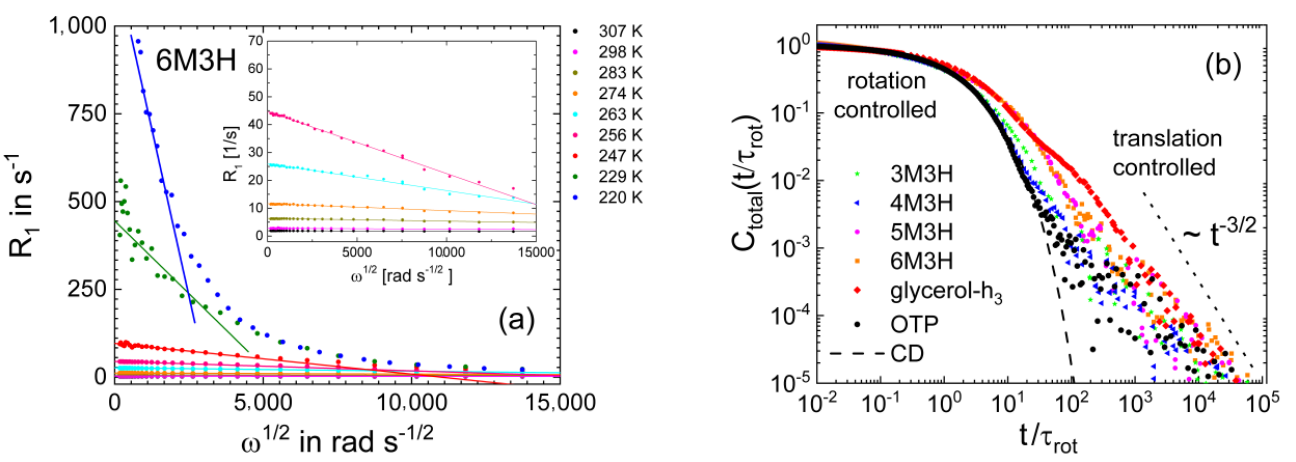
Figure 11. ( a ) 1 H spin-lattice relaxation rate R 1 as a function of the square root of the frequency, ω 1/2 . The self-diffusion coefficient D is determined from the linear part of R 1 ( ω ) via Equation (4), as indicated by the straight lines. Inset: magnification of the high-temperature data. ( b ) Normalized NMR time correlation functions derived from the susceptibility master curves of the octanol isomers (see Figure 9a), glycerol-h 3 , and o-terphenyl (OTP) in a double logarithmic representation. The dashed line is a CD function representing the rotational dynamics and the dotted line indicates a long-time t − 3/2 power law reflecting the translational dynamics.